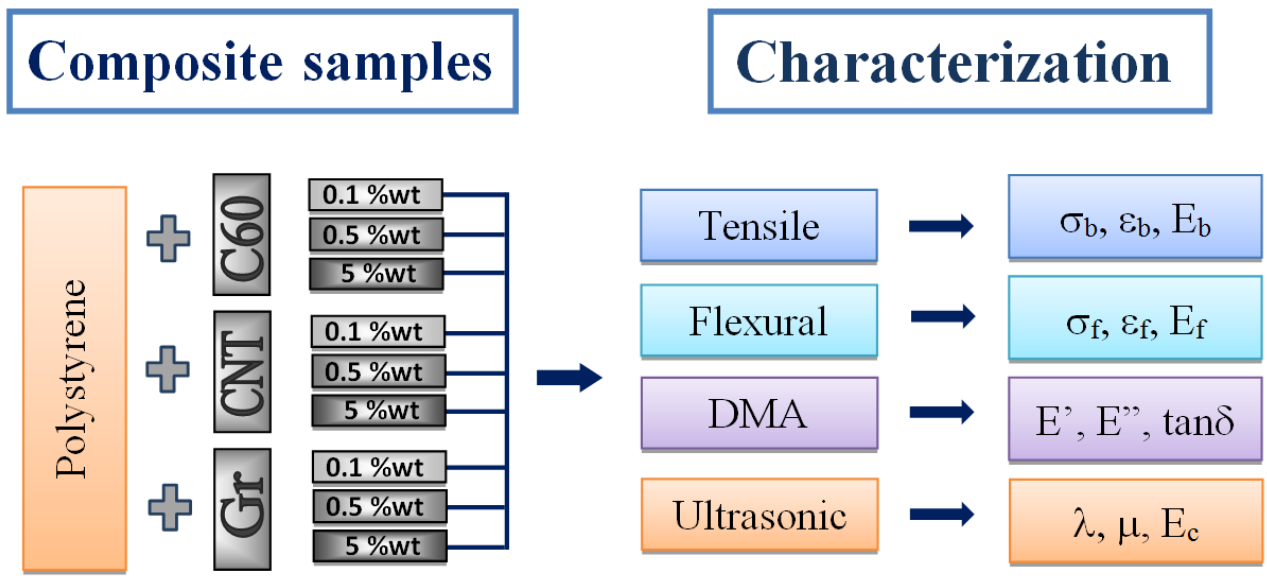
Figure 2. Flowchart of the experimental